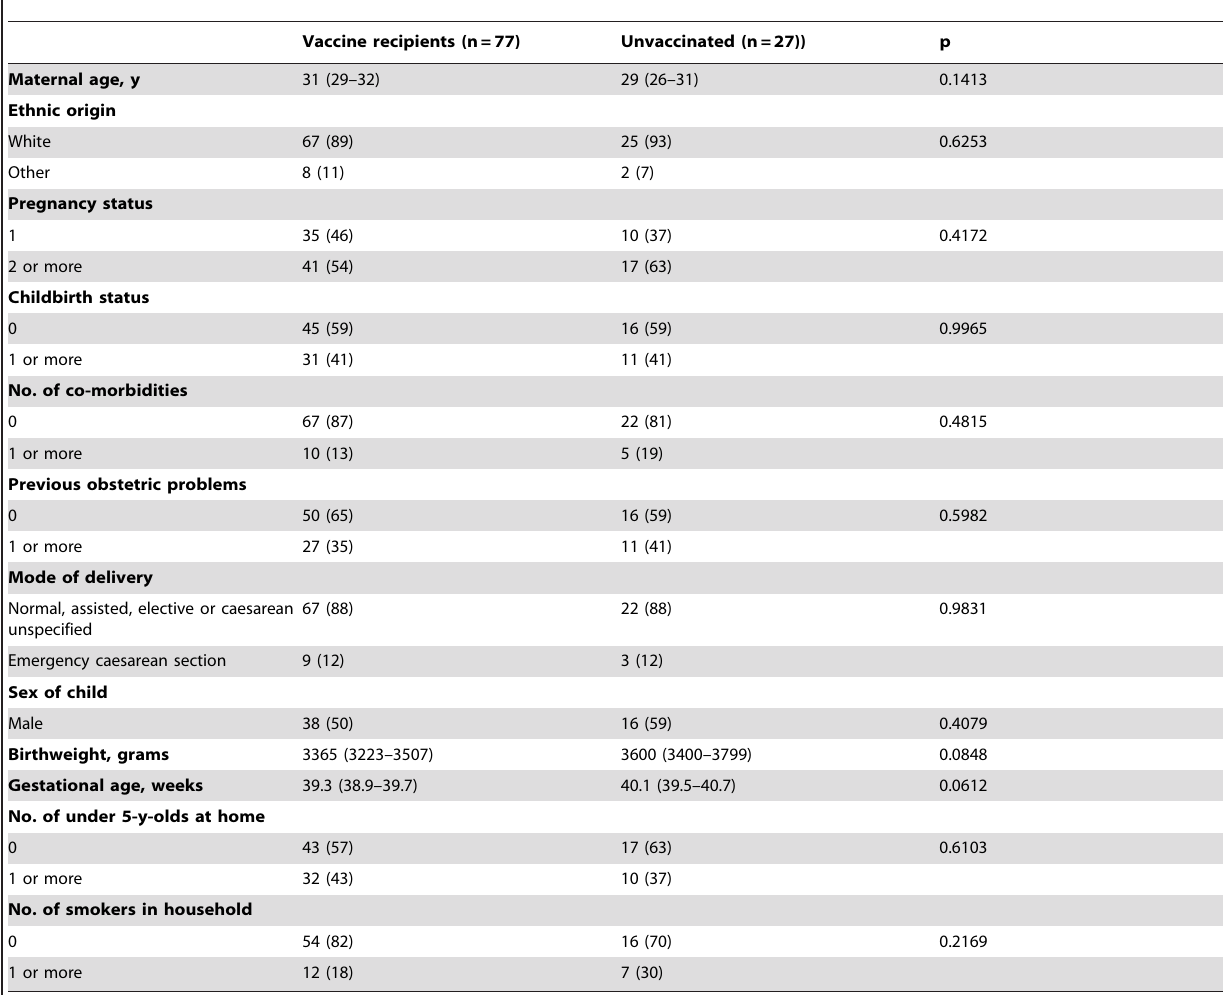
Table 1. Baseline characteristics of vaccinated and unvaccinated mothers